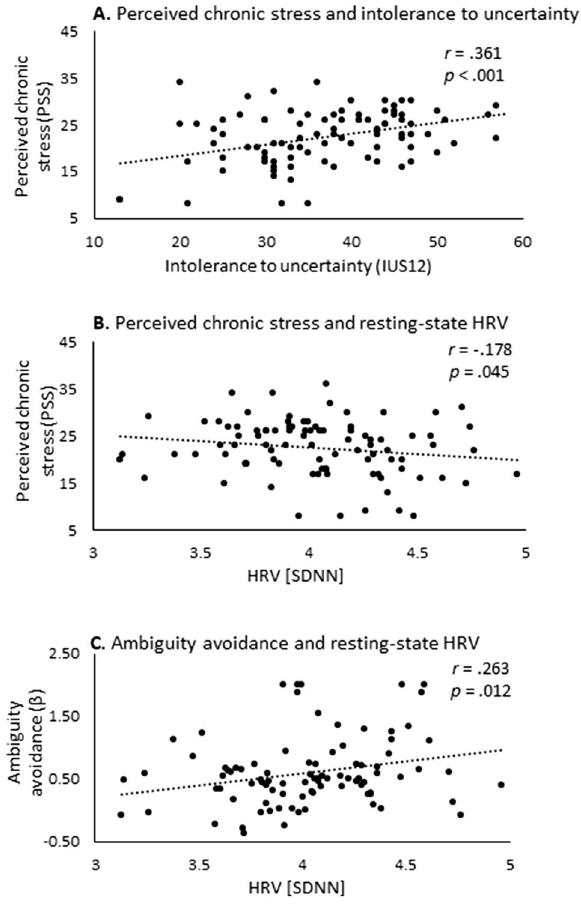
Figure 3. Perceived chronic stress, intolerance to uncertainty, physiology, and behavioral attitudes. ( A ) Positive association between perceived chronic stress and intolerance to uncertainty. ( B ) Negative associations between perceived chronic stress and resting-state HRV [SDNN]. ( C ) Positive association between behavioral attitude towards ambiguity (β) and HRV [SDNN], indicating that ambiguity avoidance is associated with higher resting- state HRV. HRV—Heart rate variability; SDNN—Standard deviation of the RR intervals.